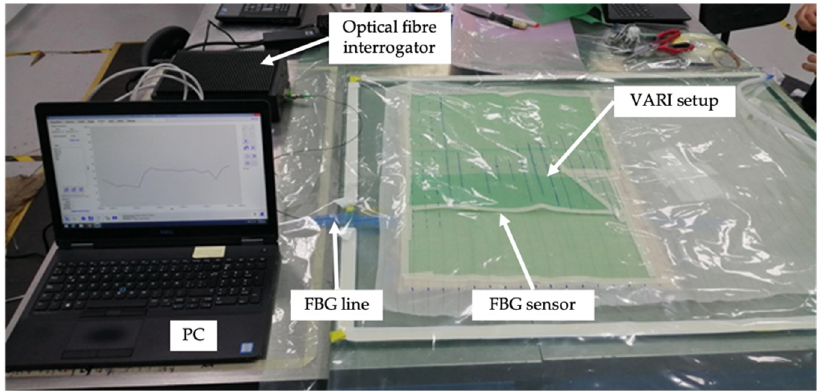
Figure 1. VARI setup for monitoring biocomposite fabrication with FBG optical fiber.